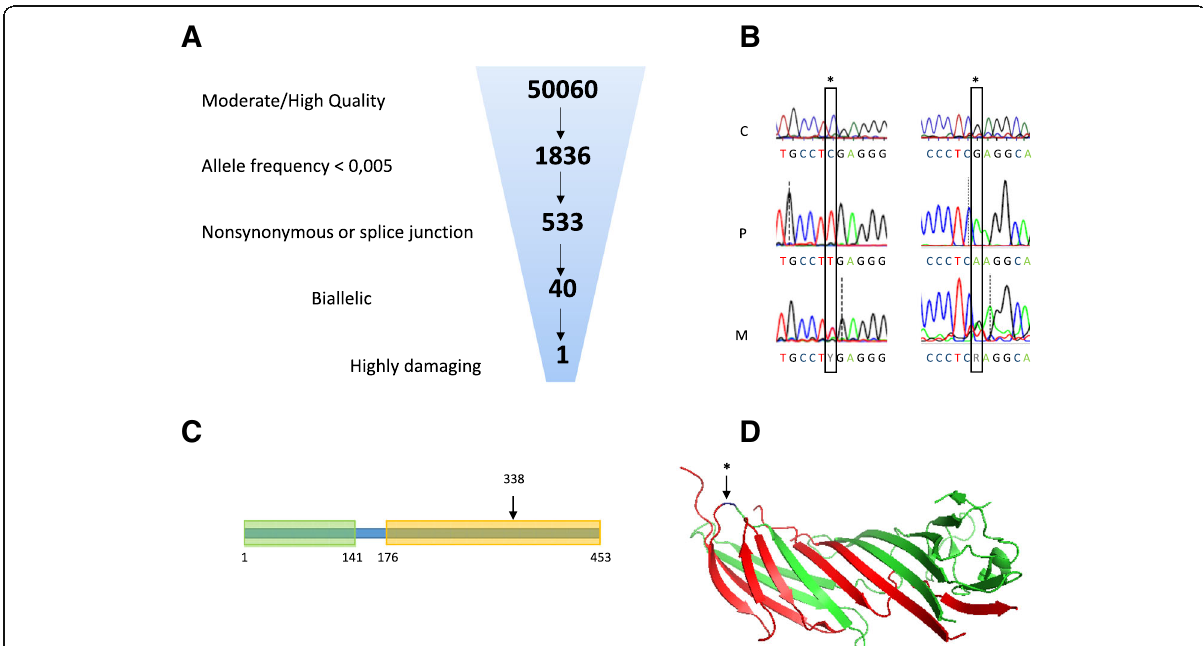
Fig. 2 AP4M1 mutation and domains. a Exome sequencing data from proband, showing the filtering parameters used to sort through the variant dataset. b Sanger sequencing of part of exon 13 of the AP4M1 gene, forward ( left ) and reverse ( right ). The C to T mutation (*) at position 1170 of the coding DNA sequence was found homozygous in the proband (P), and heterozygous in his mother (M); a normal sequence is shown in an unrelated control subject (C). c Linear presentation of the AP4M1 protein, showing the Longin-like domain (residues 1 – 141) and Mu homology domain (residues 176 – 453). Arrow , position of the Arg338X mutation. d Crystal structure (PDB 3 l81 [27]) of AP4M1 C-terminal domain (residues 160 – 453). The portion of the protein truncated by the mutation appears in